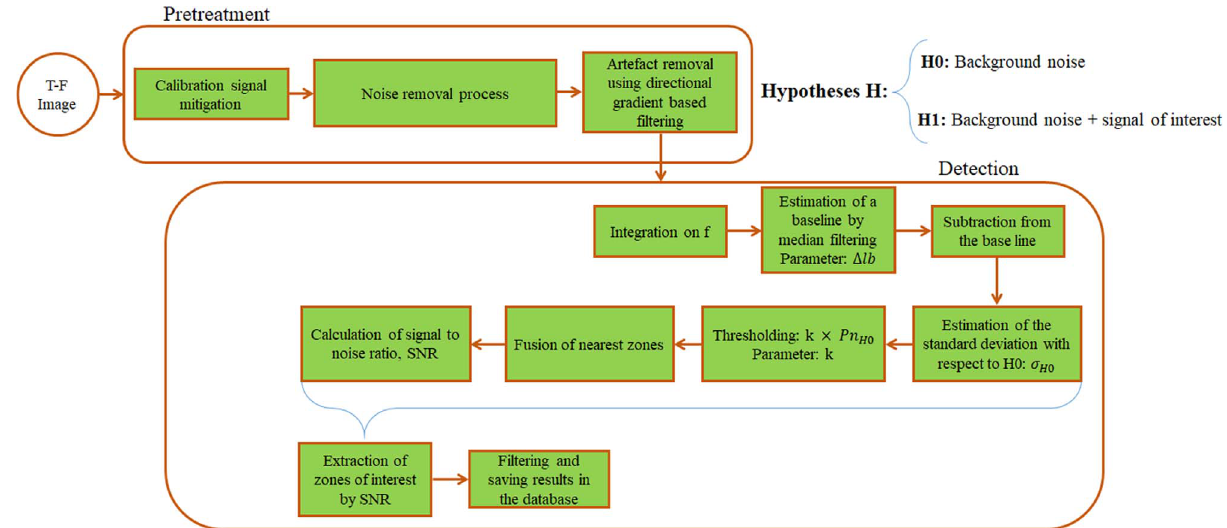
Fig. 11. Synopsis of the proposed detection system.